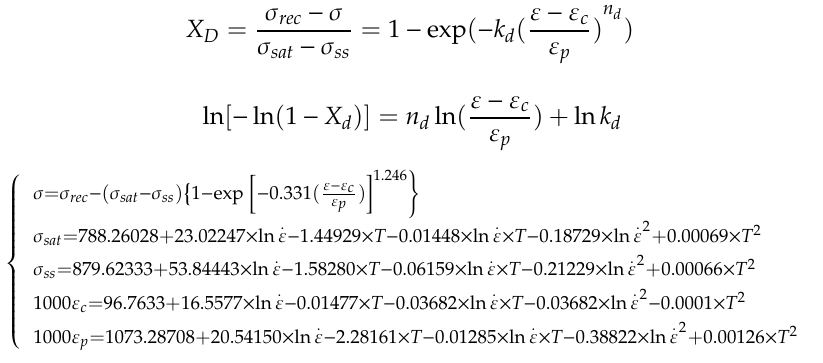
Figure 10. Correlation between the experimental values and calculated value: ( a )